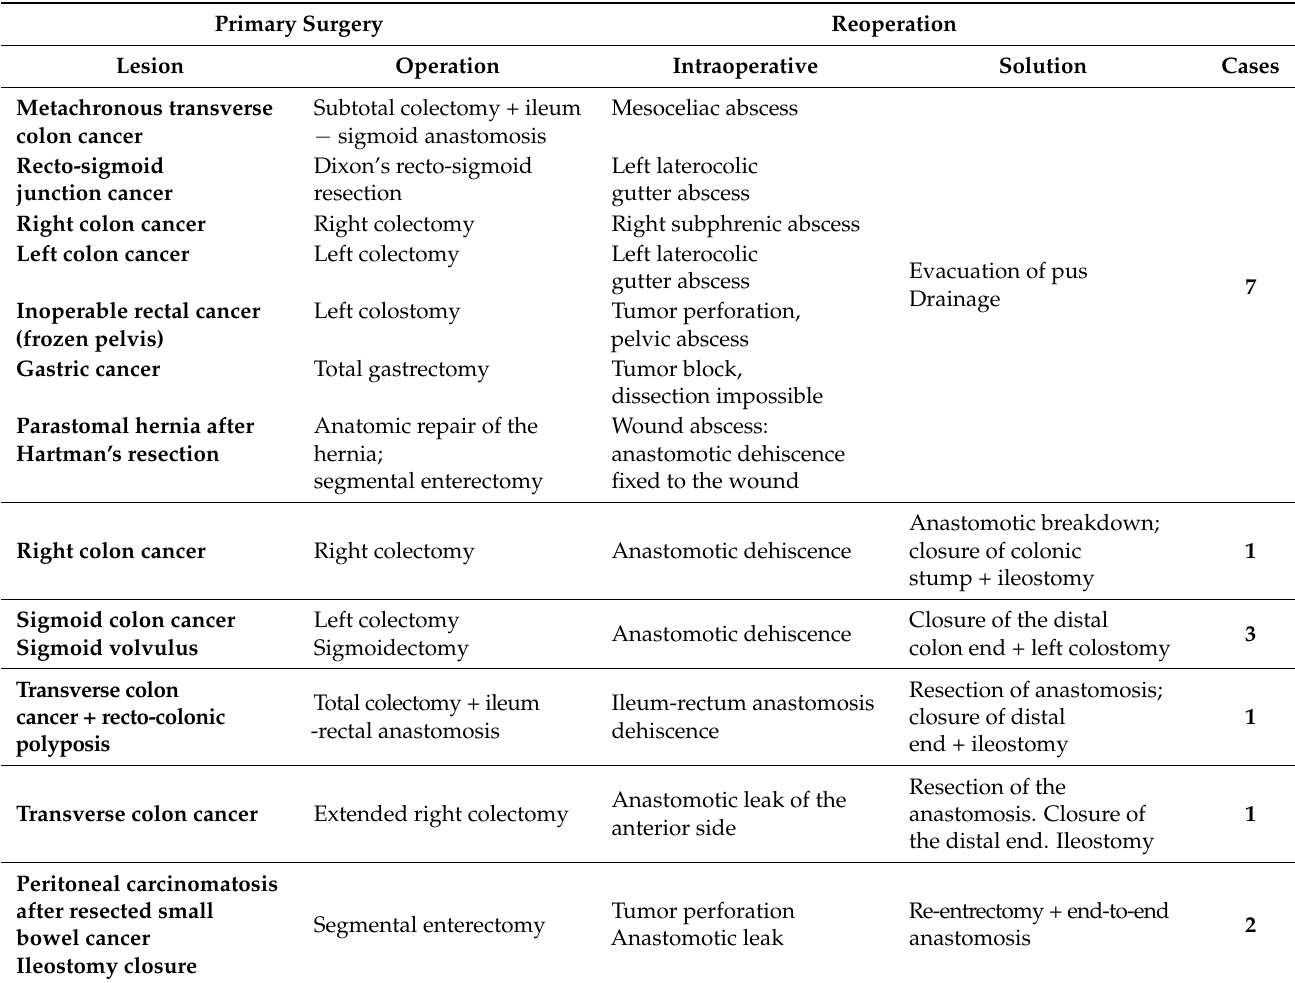
Table 3. Reinterventions: type of